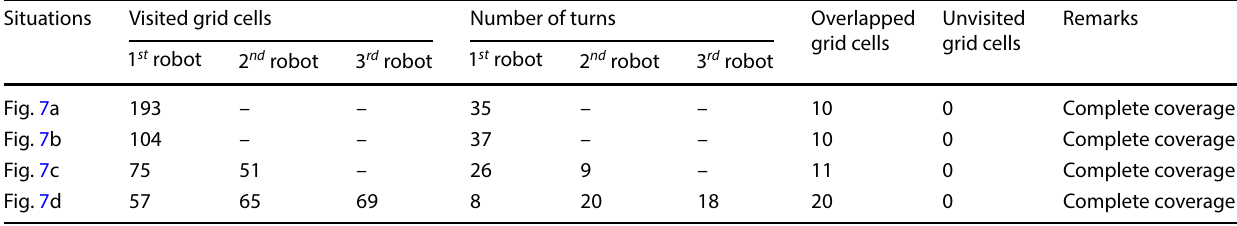
Table 4 Successful completion of complete grid coverage by single and multiple mobile robot systems Situations Visited grid